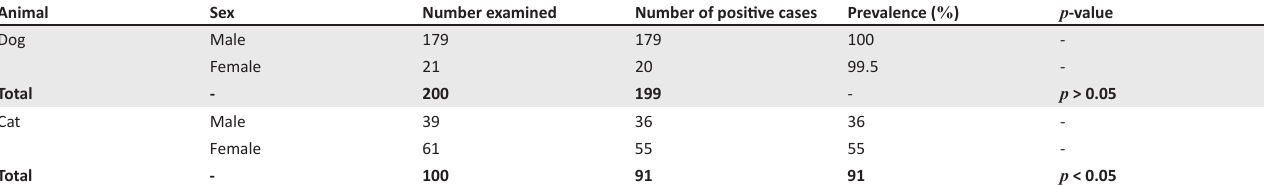
TABLE 3: Comparison of the overall prevalence of ectoparasites on male and female study animals. Animal